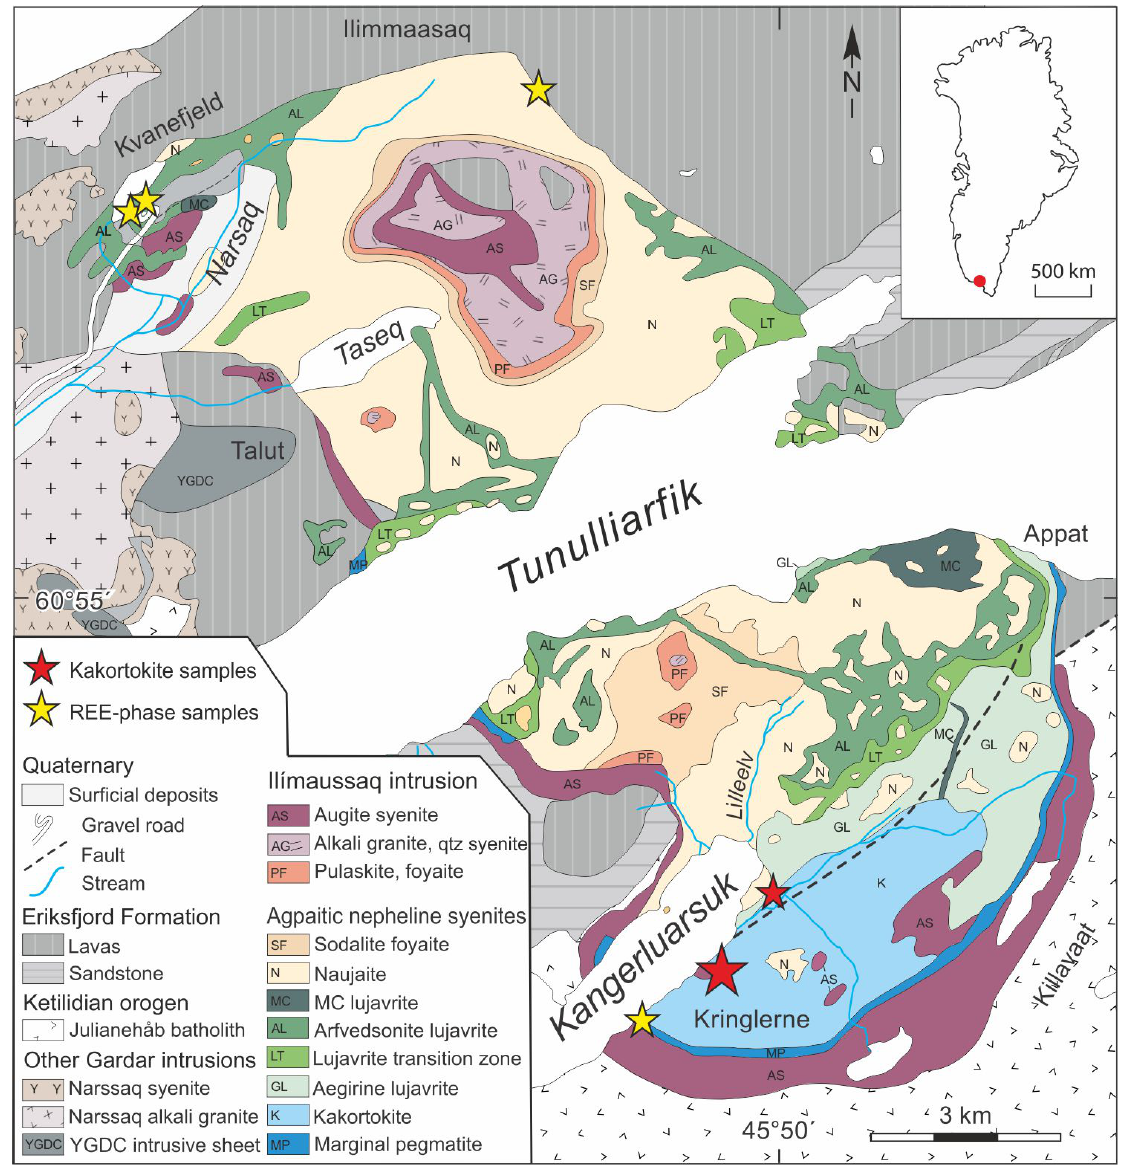
Figure 1. Geological map of the Ilímaussaq complex with sampling locations—from Borst et al. [42] modified after Upton